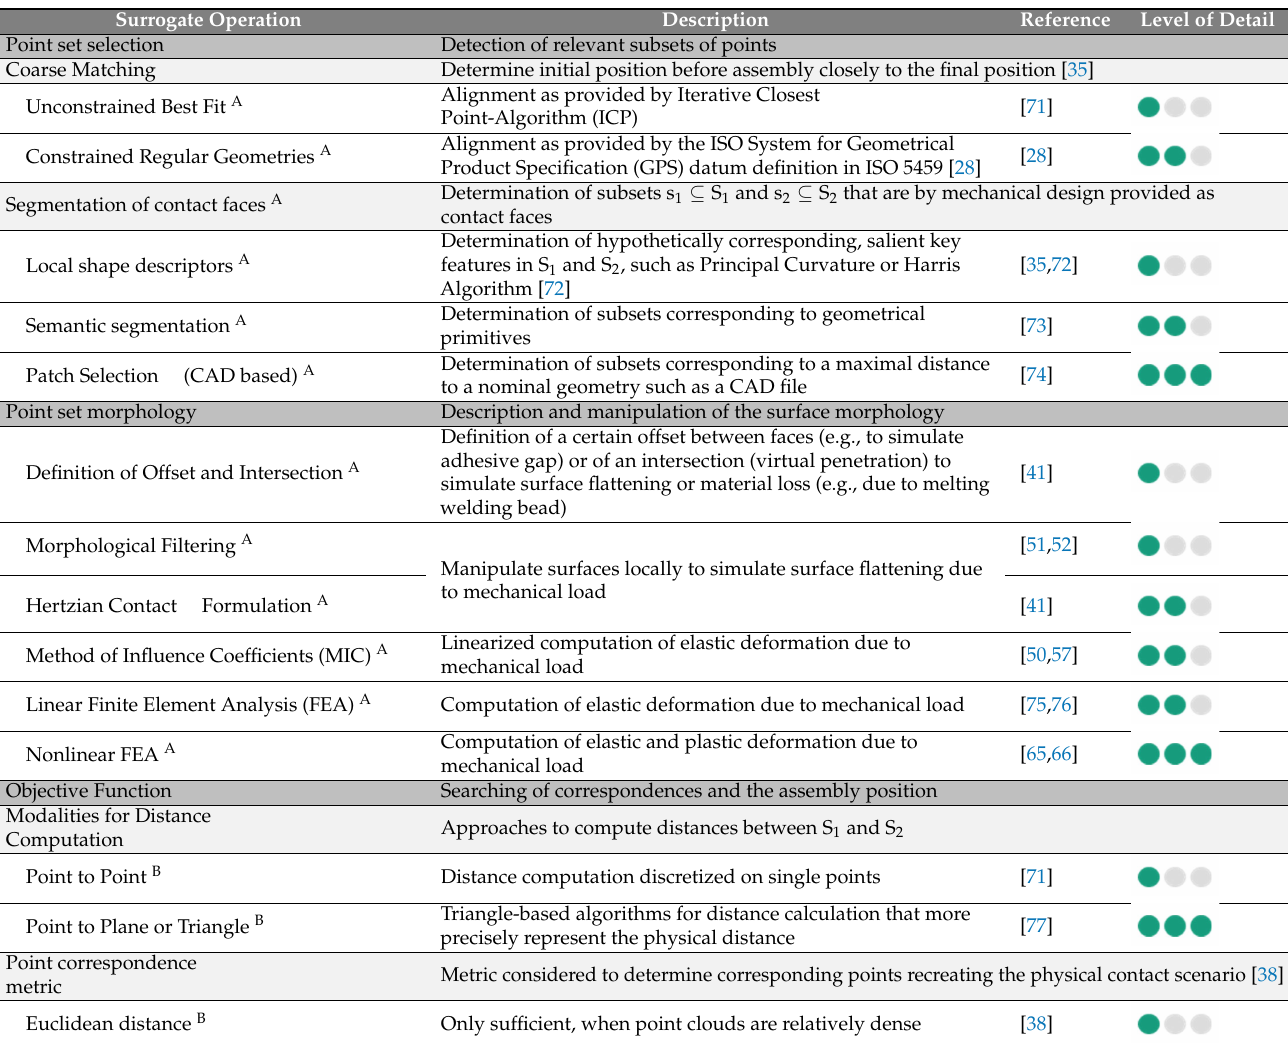
Table A1. Overview of considered Surrogate Operations (Pre-alignment SOs are denoted by superscript A, optimization constraints are denoted by superscript B). By the statement of the level of detail, the SOs are classified concerning their level of